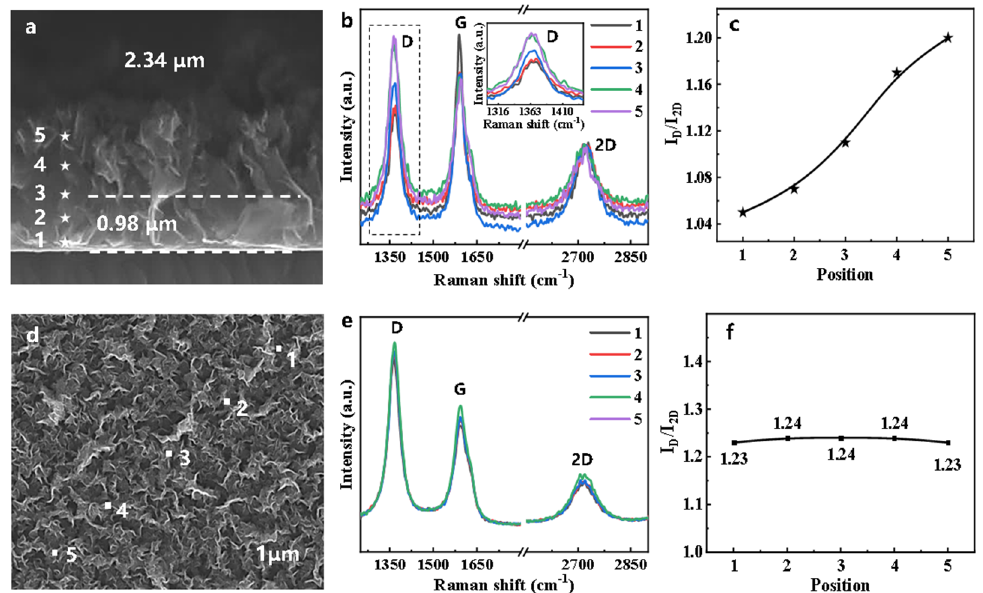
Figure 3. Raman characterizations of VG: ( a ) The cross − section SEM image of VG. The stars in ( a ) represent positions from which Raman spectra were collected. ( b ) Raman spectra of VG and ( c ) I G /I 2D ratios corresponding to the positions marked in ( a ). ( d ) The surface SEM image of VG. The dots in ( d ) represents positions from which Raman spectra were collected. ( e ) Raman spectra of VG and ( f ) I G /I 2D ratios corresponding to the positions in ( d ).